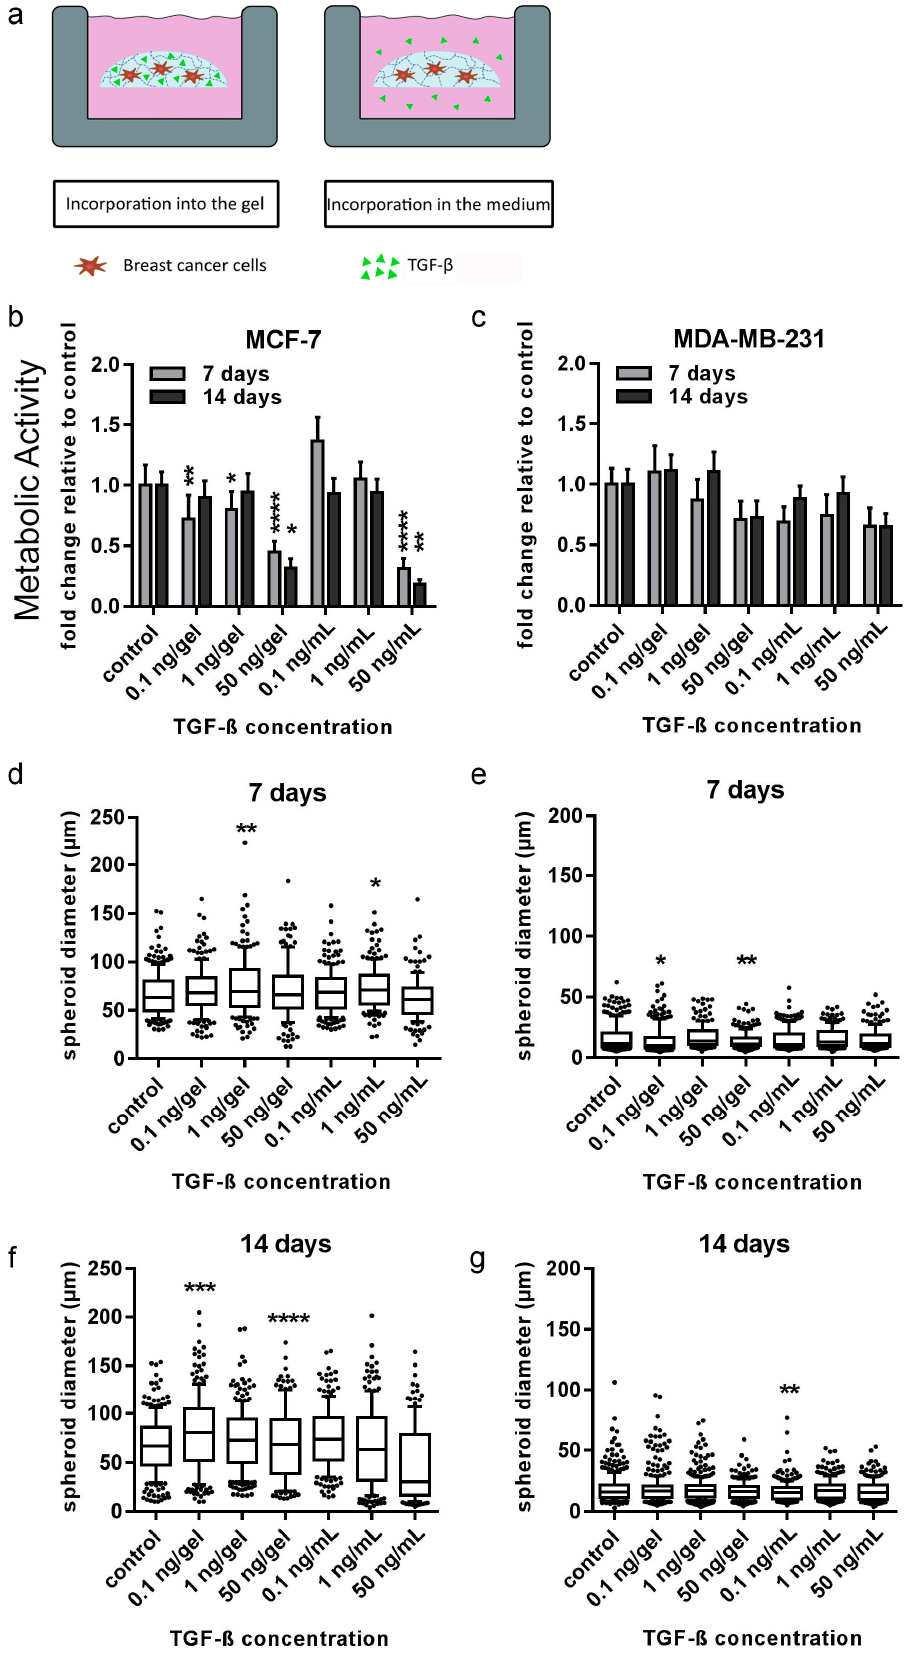
Figure 5. Cell viability and average spheroid diameter of MCF-7 and MDA-MB-231 cells when exposed to transforming growth factor beta 1 (TGF- β 1). ( a ) TGF- β 1 was incorporated into either the gel or in